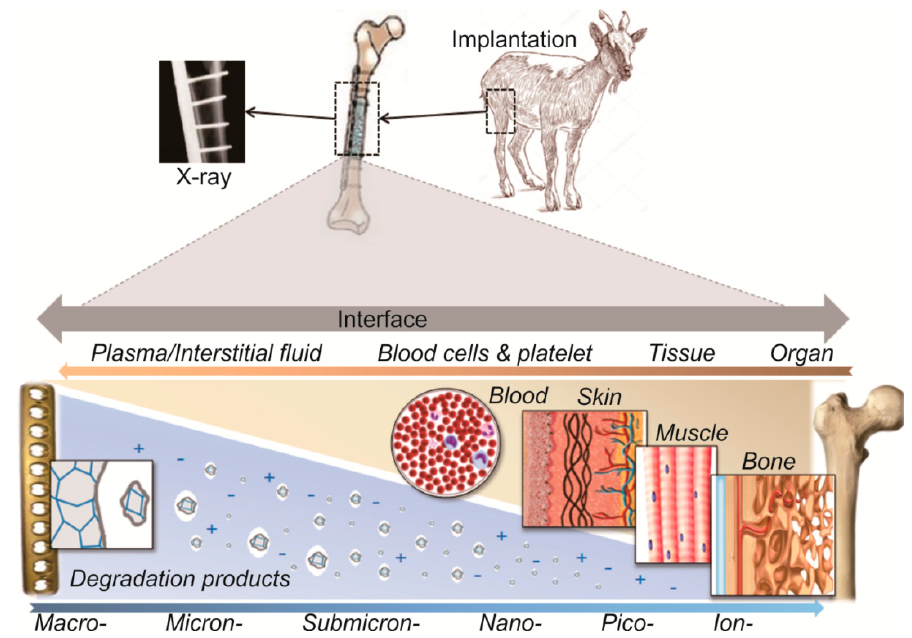
Figure 1. Schematic of potential interaction between an absorbable metal-local tissue interactions followed by the body response. Corrosion starts as the implant is inserted, then the tissue reacts to this foreign body. Corrosion products formed and released into the tissue are fragmented from micron size down to ions, transported by the blood cells and passed into different tissue depending on the implantation site, i.e., bone, muscle, skin, etc.